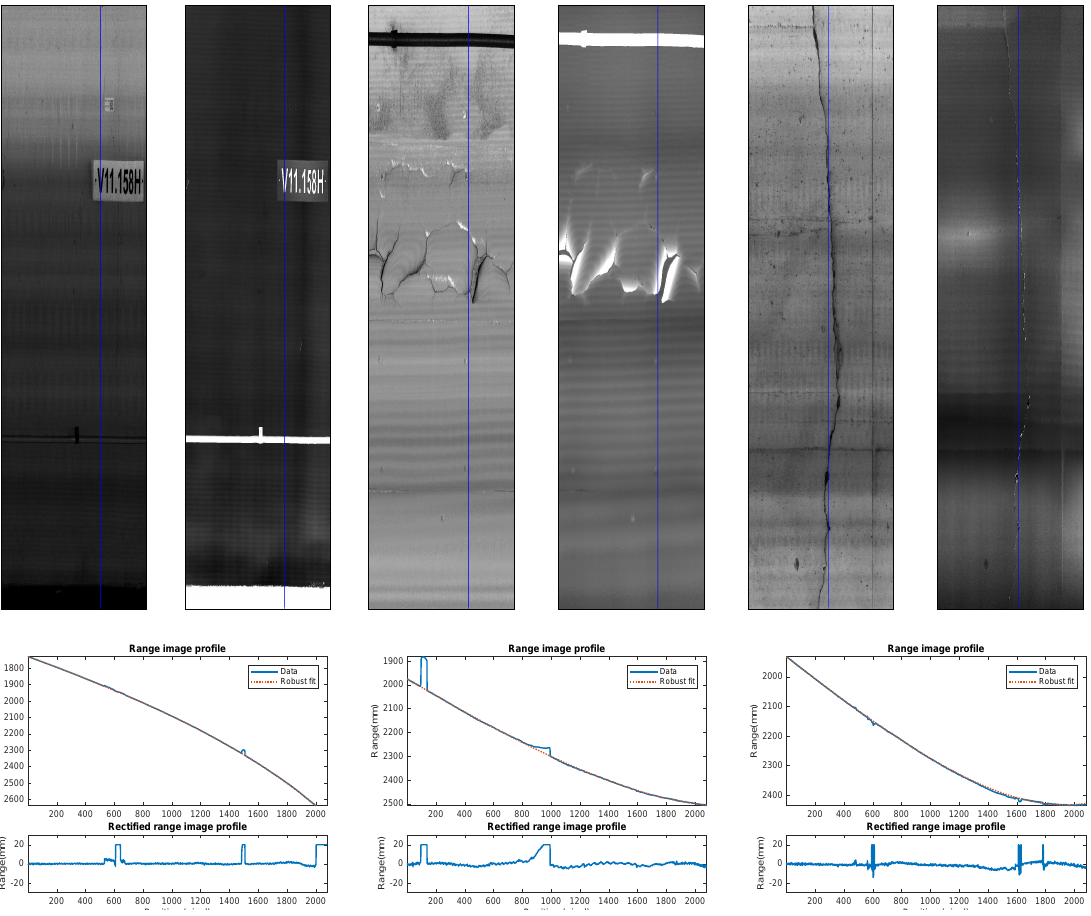
Figure 14. Top: images of range (left) and intensity (right) for 3 different acquisitions. Bottom: range profiles extracted along the column shown in blue on the images, as well as the associated rectified range